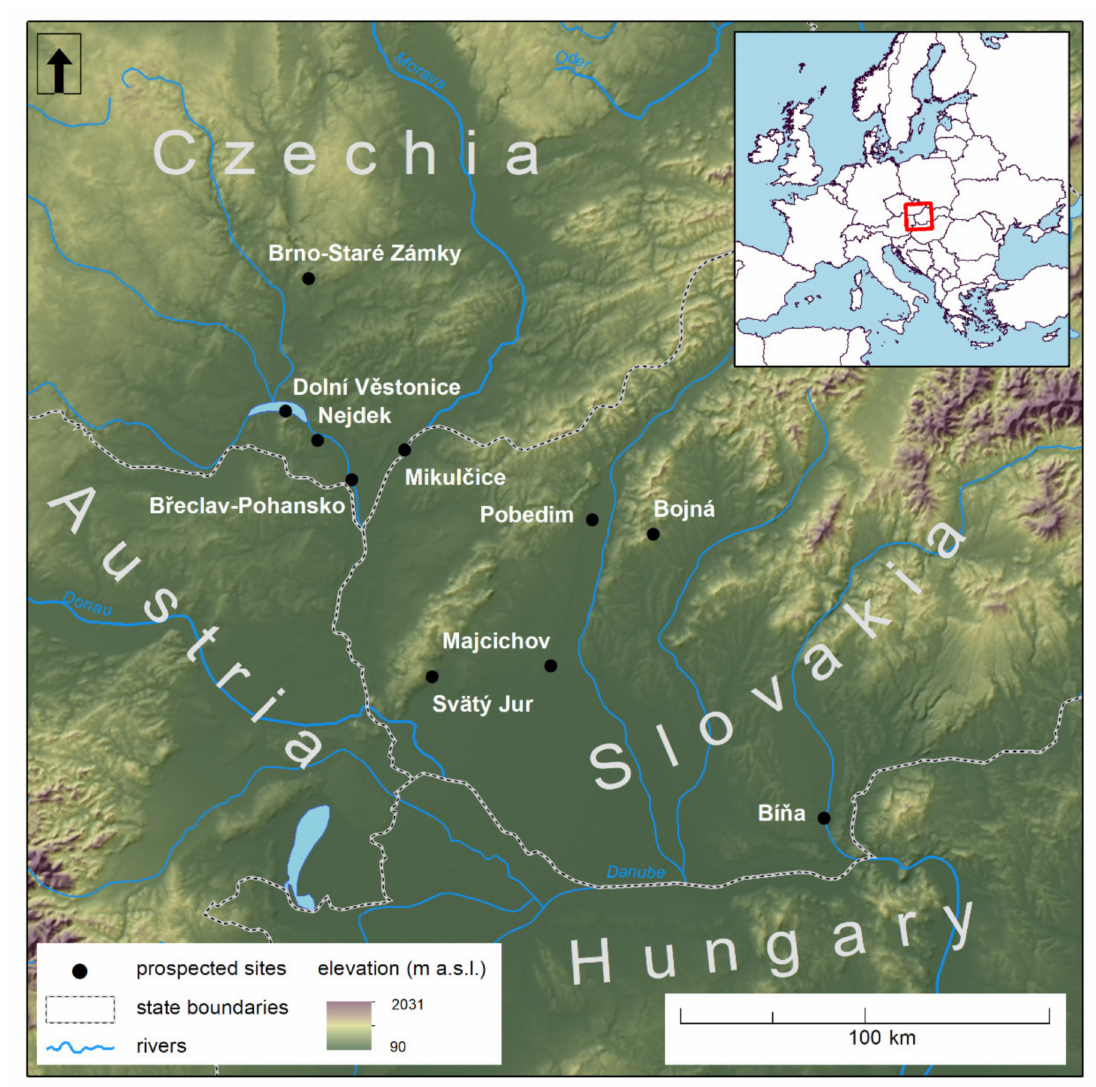
Figure 1. Locations of the surveyed